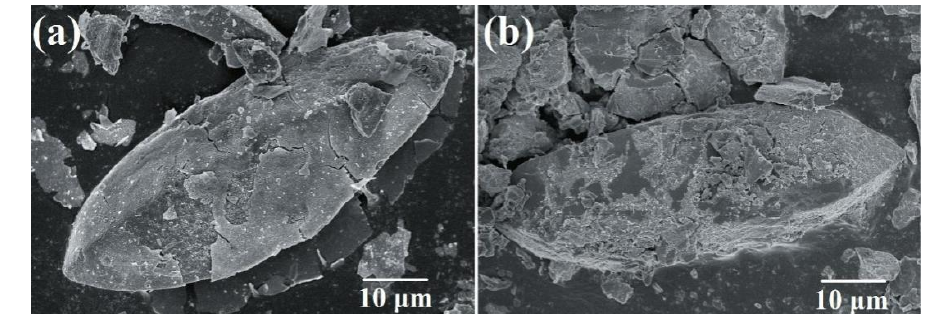
Figure 4. SEM images of ( a ) Sample 4 (initial Fe ions/scorodite molar ratio = 9%; initial reaction pH = 11; reaction time = 35 min) and ( b ) Sample 5 (initial Fe ions/scorodite molar ratio = 9%; initial reaction pH = 12; reaction time = 15 min).